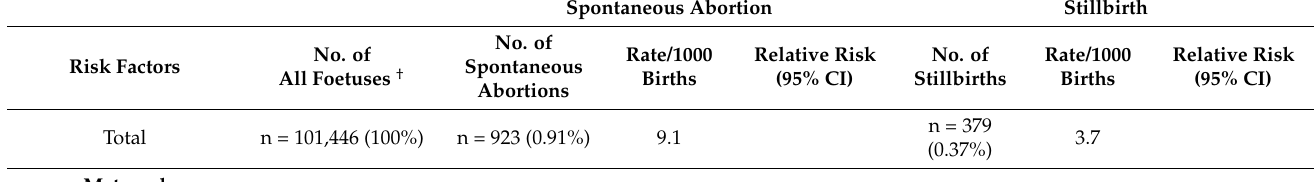
score, working hours, and sitting hours were treated as continuous variables, while the adjustment factors of multiple births and social factors were treated as categorical variables, as shown in Table 1. All subjects with one or more missing values in the adjustment variables were excluded from each analysis. Table 1. Characteristics of the study population and risk factors associated with spontaneous abortion and stillbirth. Spontaneous Abortion